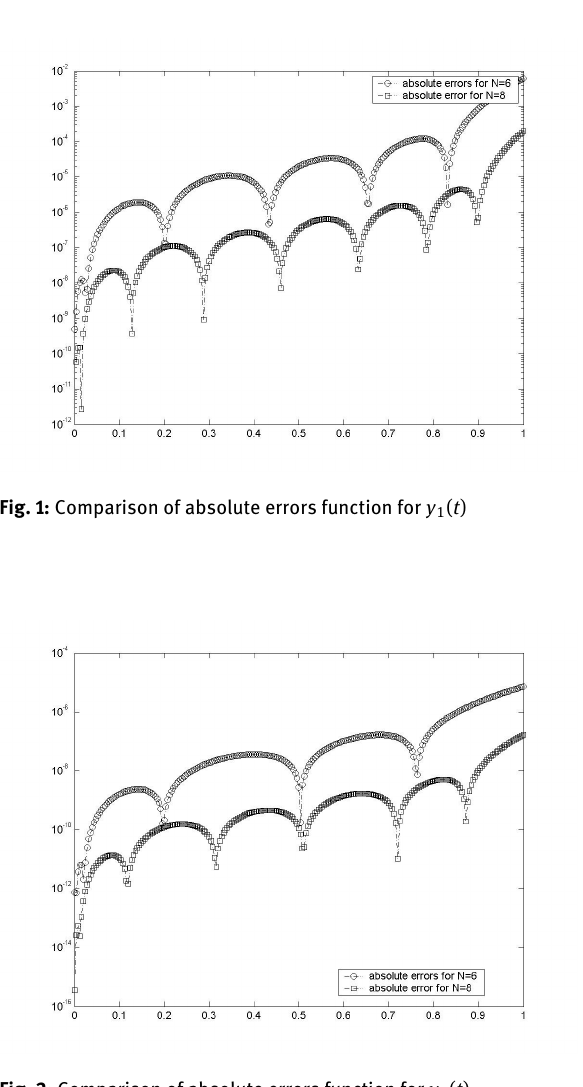
Fig. 2: Comparison of absolute errors function for y 2 ( t